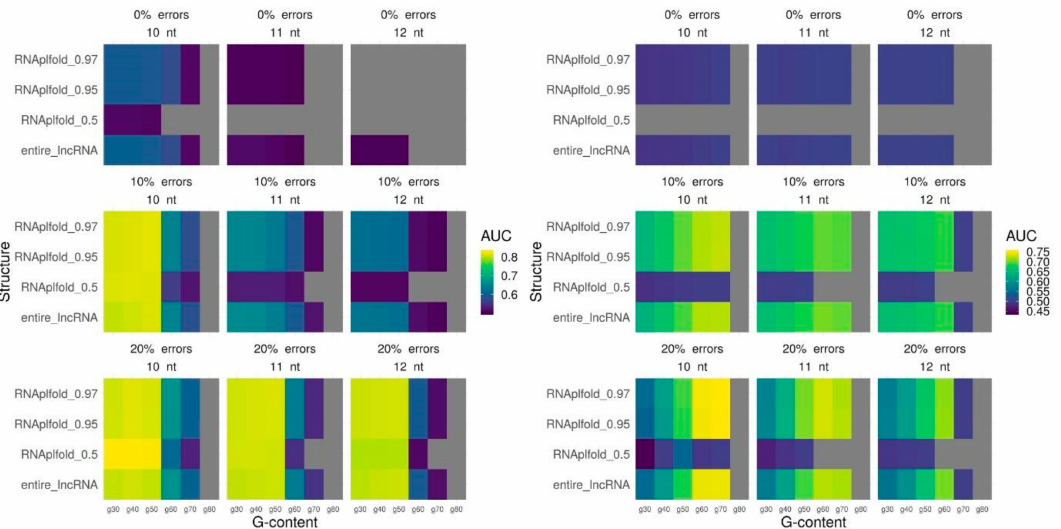
Figure 3. Triplexes prediction quality with di ff erent triplexes parameters: minimum length (nt), maximum error-rate, minimum G-content for the entire lncRNA and three RNAplfold thresholds for selection of single-stranded fragments. Prediction quality is measured by AUC (colored scheme), gray color means no triplexes predicted. MEG3 lncRNA (left panel) DACOR1 lncRNA (right